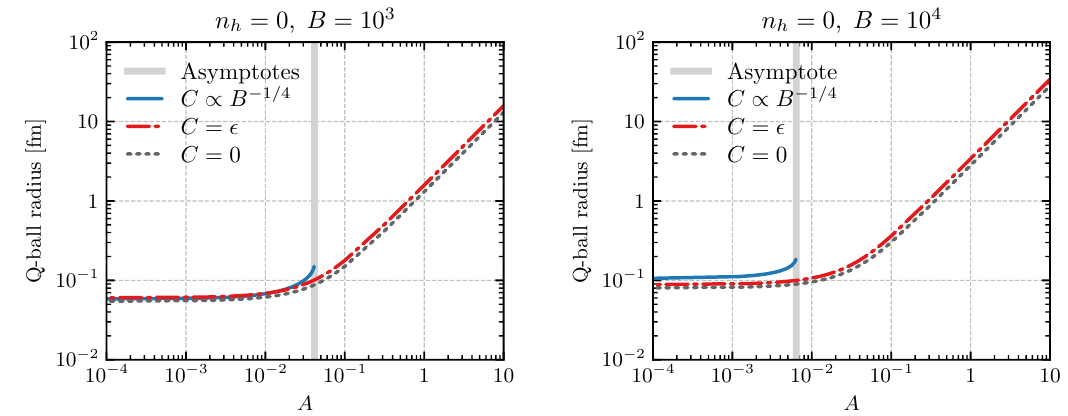
Figure 4 . The Q-ball radius in [fm] with Q = 10 6 . The three curves correspond to different values of the constant B ; see text for details. The thick grey lines behind each curve (left panel) are obtained from the analytic expressions in the two limits of large and small A